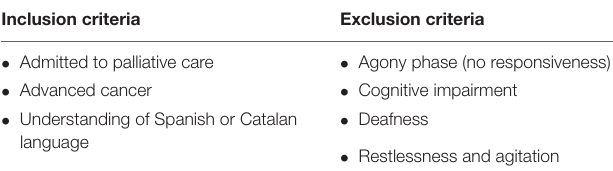
TABLE 1 | Patients’ inclusion and exclusion criteria.